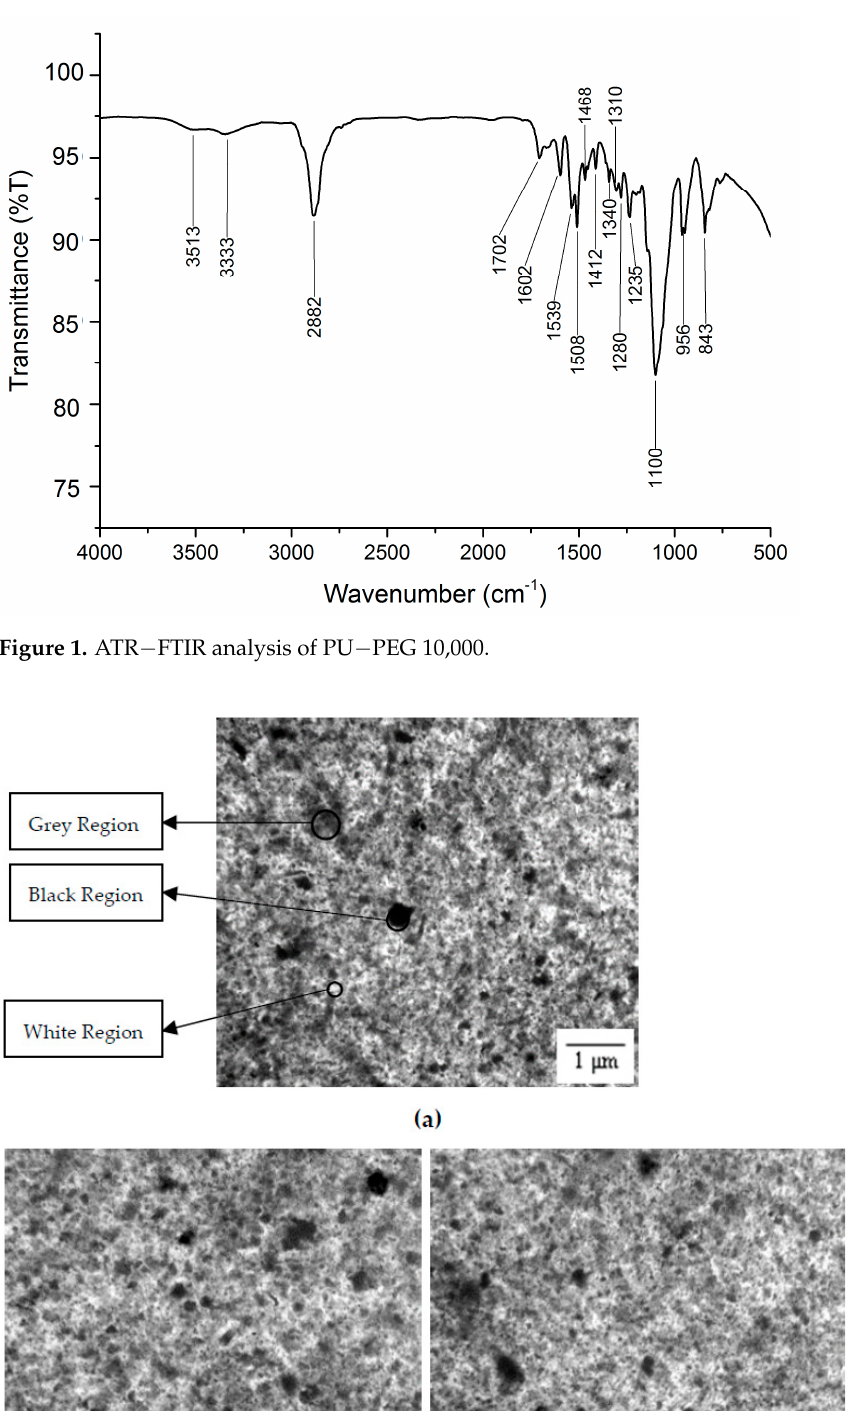
Figure 2. Transmitted light microscopic image of ( a ) PU − PEG 10,000, ( b ) PU − PEG 8000, ( c ) PU − PEG 6000, ( d ) PU − PEG 4000, and ( e ) PU − PEG 2000 . 3.3. Surface Morphology A reflected light microscope was used to investigate the surface morphology of the PU matrix (Figure 3). Pores of different sizes were found on the surface of the PU matrices. The pore formation was due to phase separation which occurred due to the crosslinking of the S − PANi with the PU, as well as the incompatibility of the soft (PEG) and hard seg- ment (MDI) in the PU [57,78,79]. It was also due to the hydrogen bonding-induced poly- meric-rich and solvent-rich region in the PU matrices, which upon drying, caused the sol- vent in the solvent-rich region to evaporate [80]. As the molecular weight of the PEG